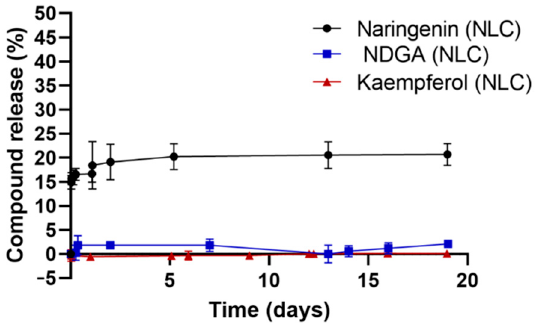
Figure 2. In vitro release profile of the developed NC-loaded NLCs in HEPES buffer (mean ± SD, n = 3).